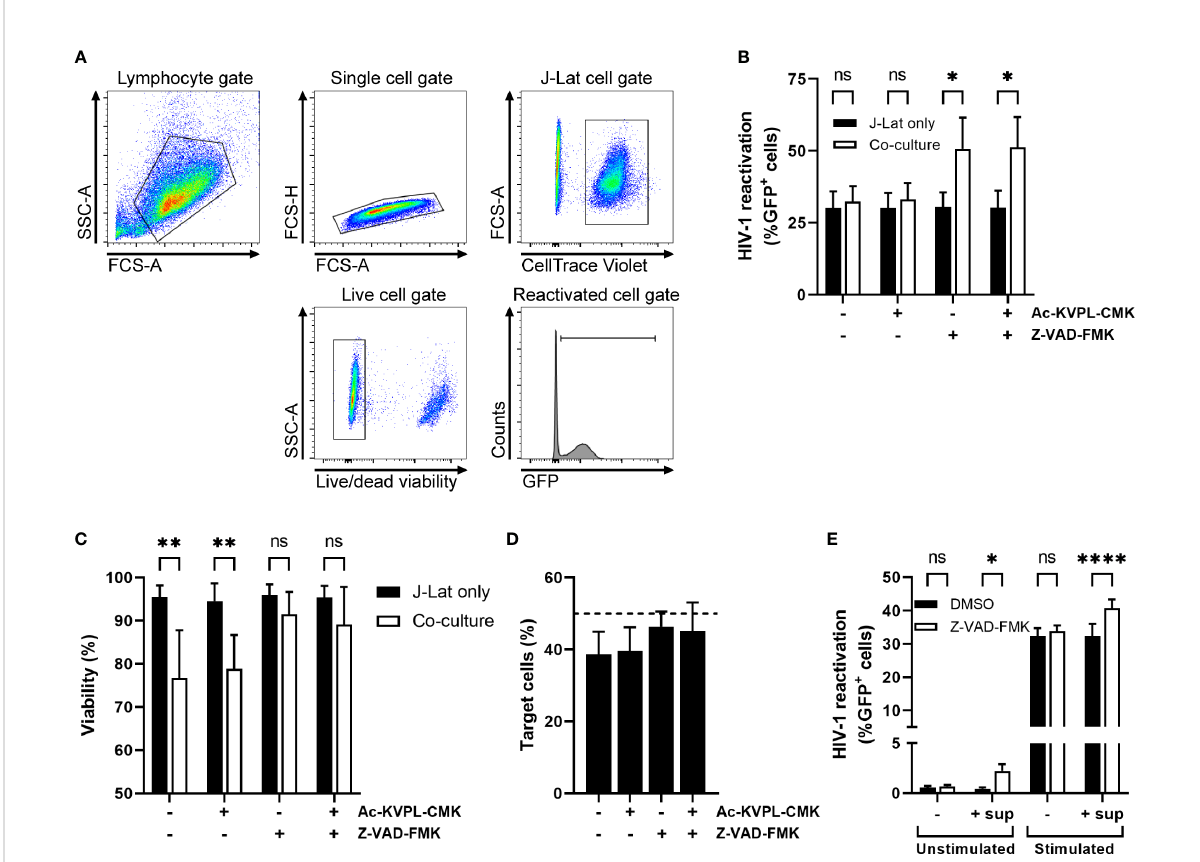
FIGURE 1 Z-VAD-FMK-treated NK cells induce HIV-1 reactivation from latency. (A) Gating strategy in our co-culture cell model for fl ow cytometry analysis. (B) HIV-1 latently infected J-Lat cells stimulated with LRA prostratin were cultured in the presence of GrM-inhibitor Ac-KVPL-CMK or pan- caspase inhibitor Z-VAD-FMK either with or without KHYG-1 NK cells. HIV-1 reactivations as measured by GFP-positivity was assessed by fl ow cytometry. (C) Cell viability of J-Lat cells was assessed by near infrared viability dye staining and fl ow cytometry. (D) The percentage of CellTrace Violet-positive J-Lat cells in co-cultures was measured by fl ow cytometry. (E) Unstimulated or prostratin-stimulated J-Lat cells were incubated with supernatants of Z-VAD-FMK-treated NK cells. HIV-1 reactivations as measured by GFP-positivity was assessed by fl ow cytometry. Data points are plotted as mean ± SD from three individual experiments. (ns, non-signi fi cant; *p < 0.05, **p < 0.01, ****p < 0.0001;